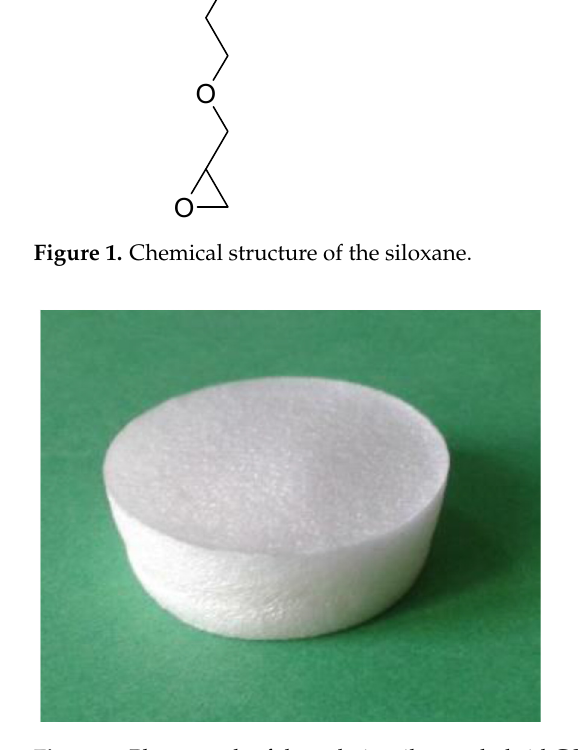
Figure 2. Photograph of the gelatin–siloxane hybrid GS 1:1 (gelatin:siloxane mass ratio 1:1).